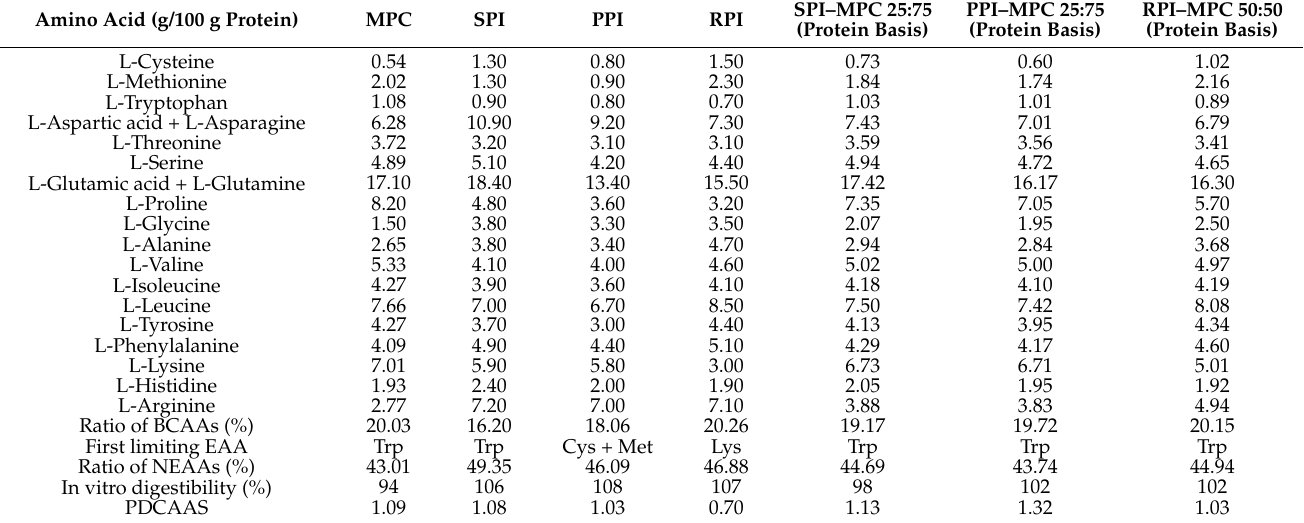
Table 1. Total amino acid composition (g/100 g protein), in vitro digestibility, first limiting essential amino acid, ratio of non-essential amino acids to total amino acids (%), ratio of branched chain amino acids to total amino acids (%) and protein digestibility corrected amino acid score of soy, pea and rice protein isolate, milk protein concentrates and plant protein isolate–MPC